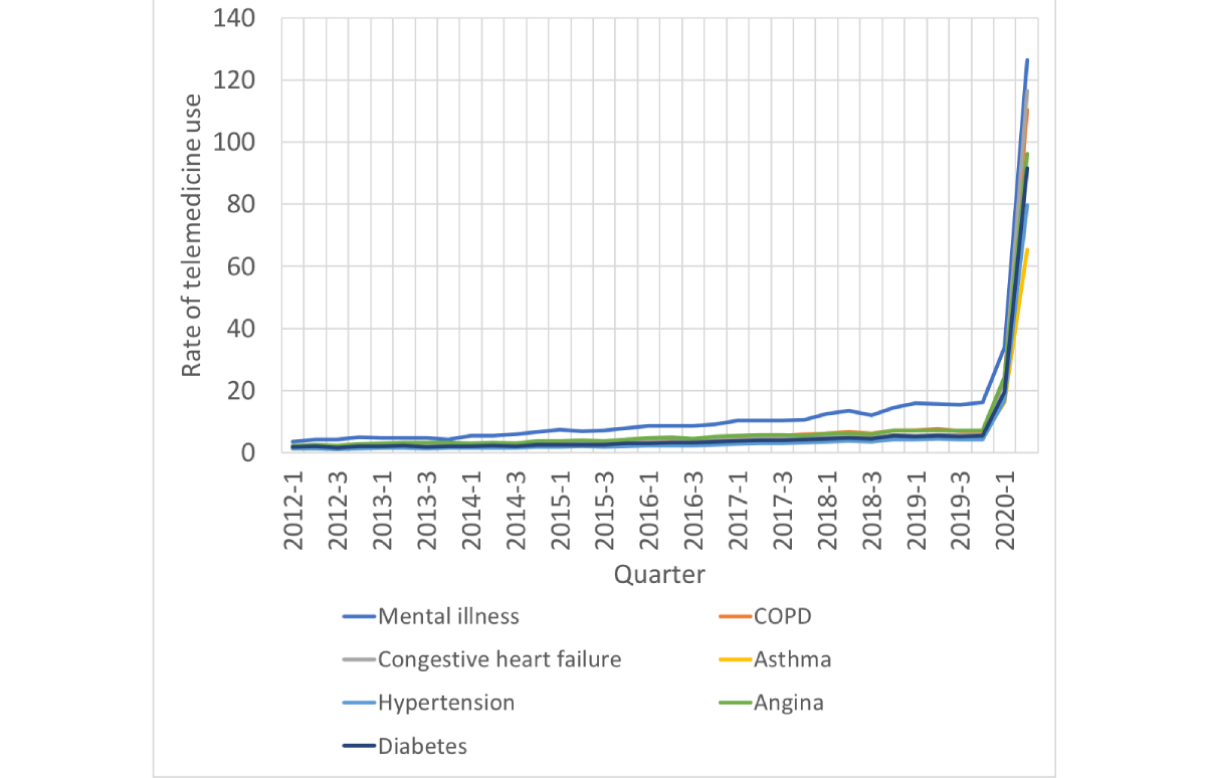
Figure 2. Rate of telemedicine visits per 100 rural patients by chronic disease, 2012-2020. COPD: chronic obstructive pulmonary